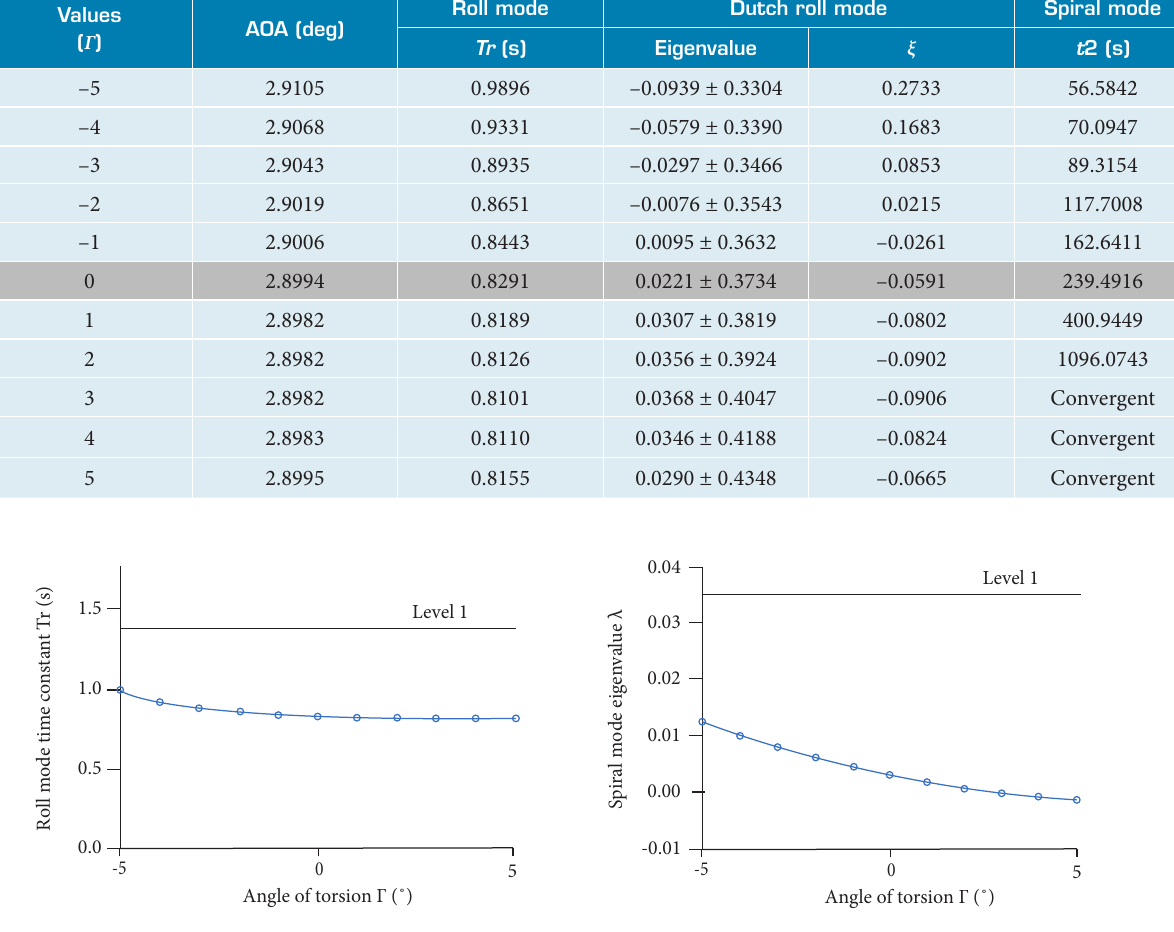
Table 7. Influence of Γ on lateral-directional dynamic stability.